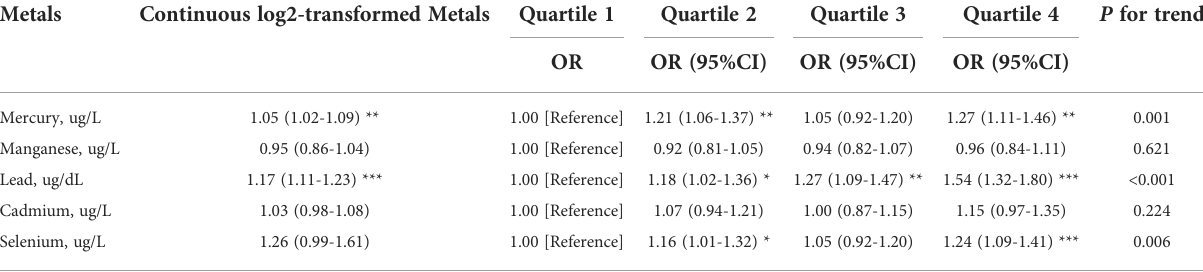
TABLE 3 Multiple logistic regression associations of blood metal levels with hyperuricemia in adults.